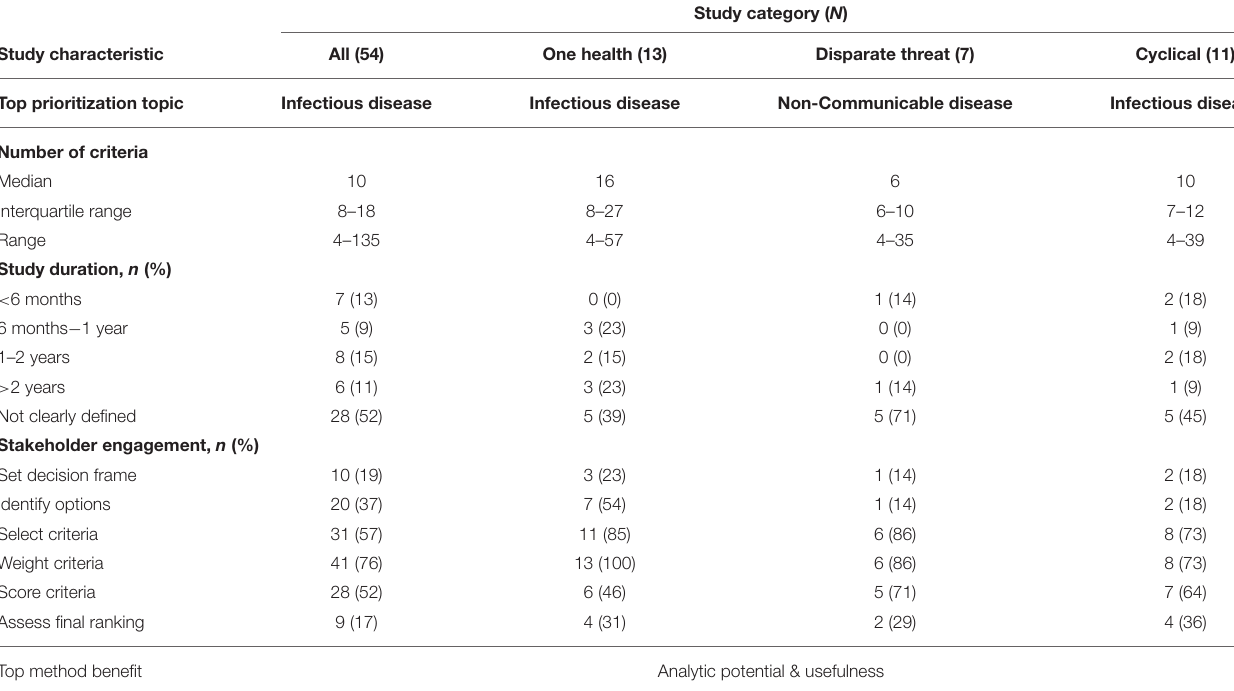
TABLE 2 | Summary of the 54 published studies by study categories and characteristics published between 2010 and 2021 from OECD